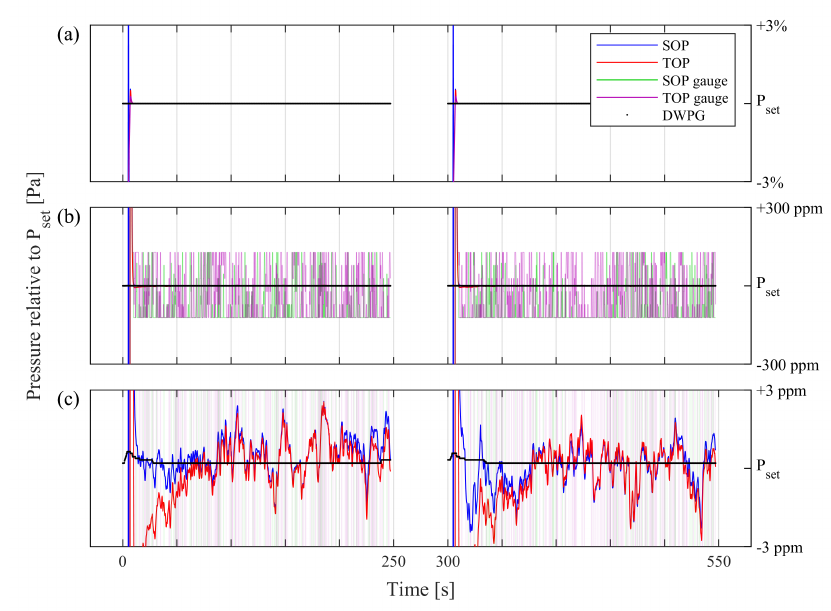
Figure 7. The 250 s parts of two consecutive (300 s long) gas modulation cycles when the measure- ment cavities contain gas for a DWPG set pressure of 16 kPa. The three panels display the same data centered around the set pressure but with dissimilar y-scales: in panel ( a ) with a scale of ± 3%; panel ( b ) with a scale of ± 300 ppm; and panel ( c ) with a scale of ± 3 ppm. Black curves: the DWPG; green curves: the SOP gauge; purple curves: the TOP gauge; blue curves: the SOP; and red curves: the